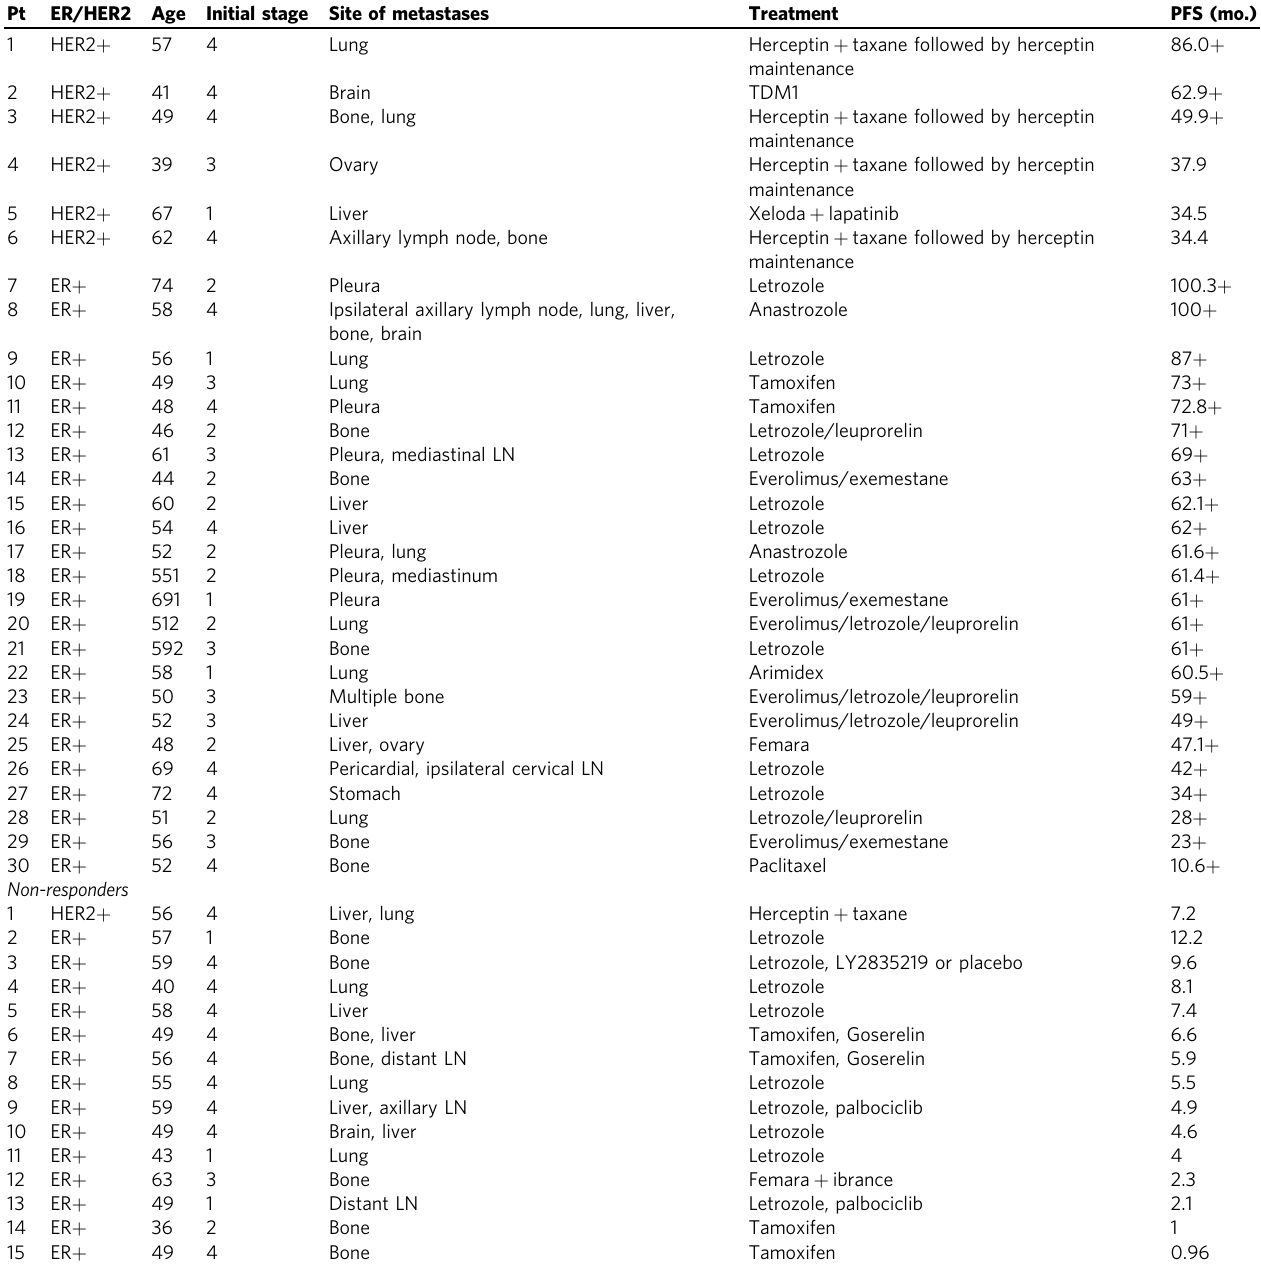
Table 1 Clinical characteristics of all patients. Pt ER/HER2 Age Initial stage Site of